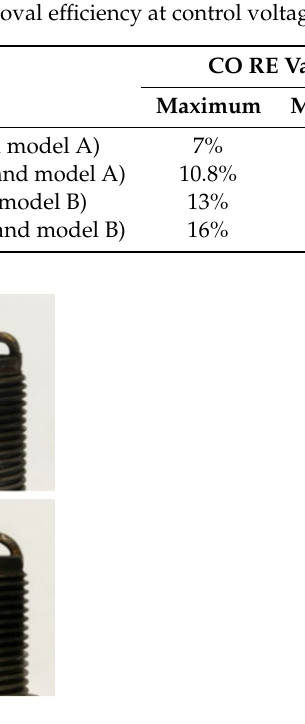
Figure 19. A photographic view of NTP reactor ( a ) platinum and ( c ) iridium alloy before this experiment and ( b ) platinum and ( d ) iridium alloy after this